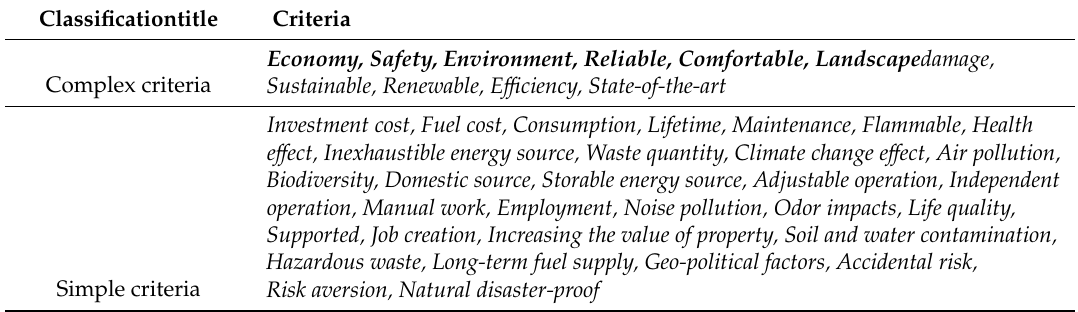
Table 1. List of complex and simple criteria used in the